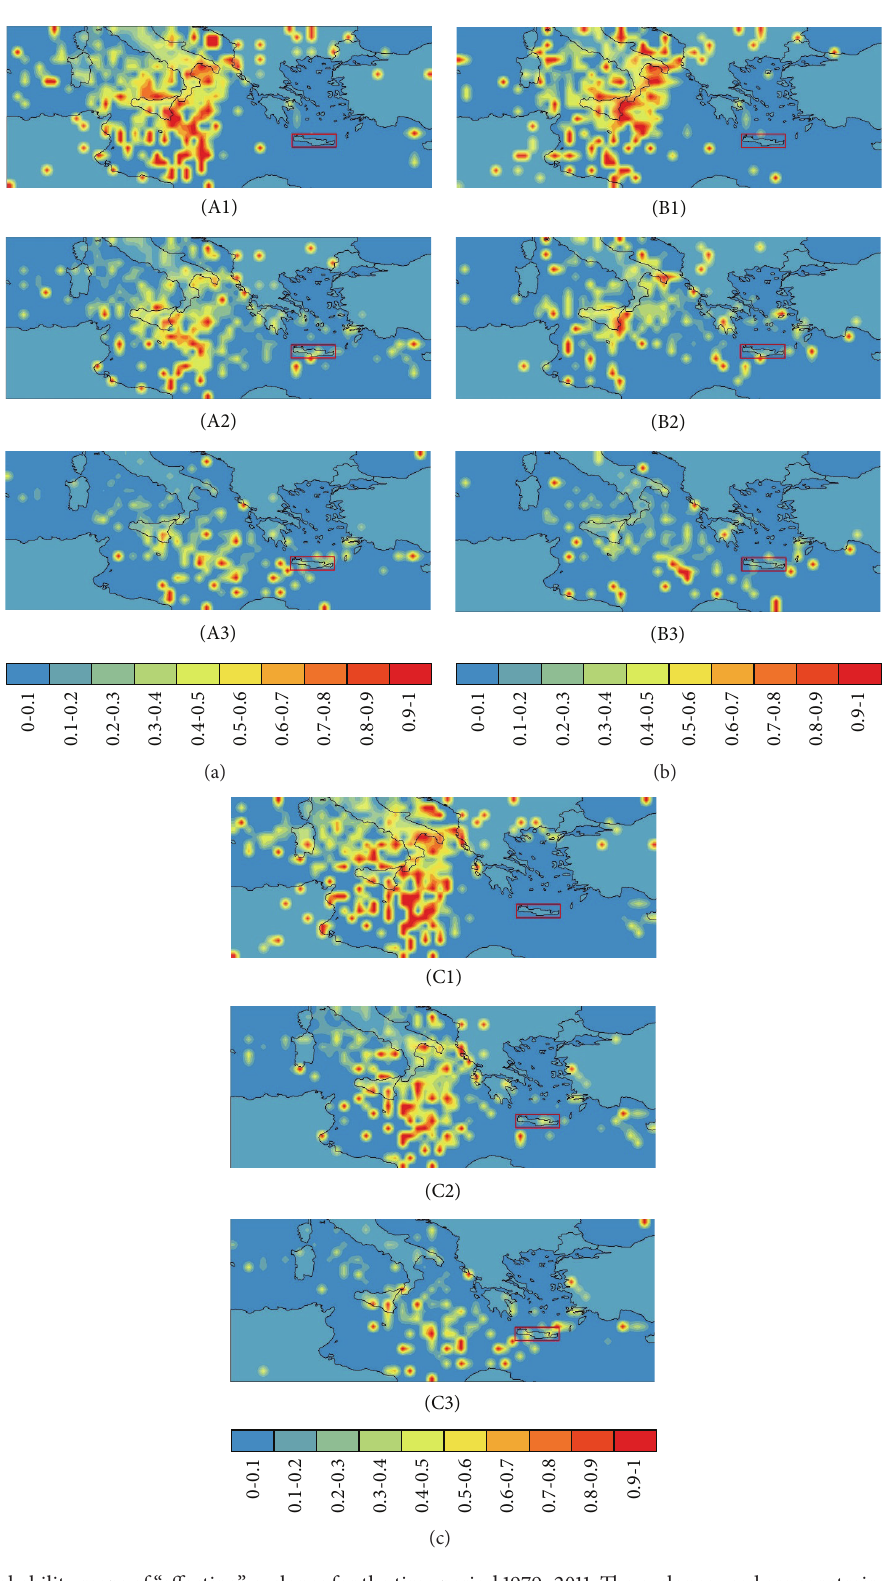
Figure 6: Spatial probability maps of “affecting” cyclones for the time period 1979–2011. The cyclones used are constrained on their (a) depth, (b) radius, and (c) intensity for (1) light, (2) medium, and (3) heavy rain